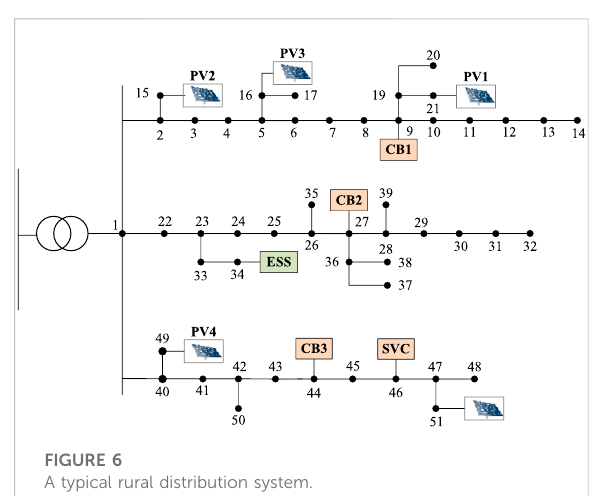
FIGURE 6 A typical rural distribution